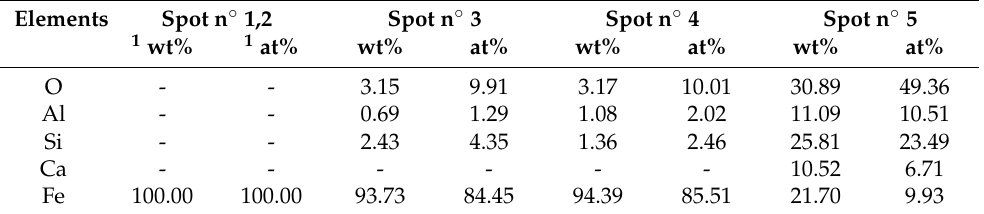
Table 4. Elemental composition (EDS data) of the (hematite + W-PVC + clay) mixture treated at 1025 ◦ C for 4